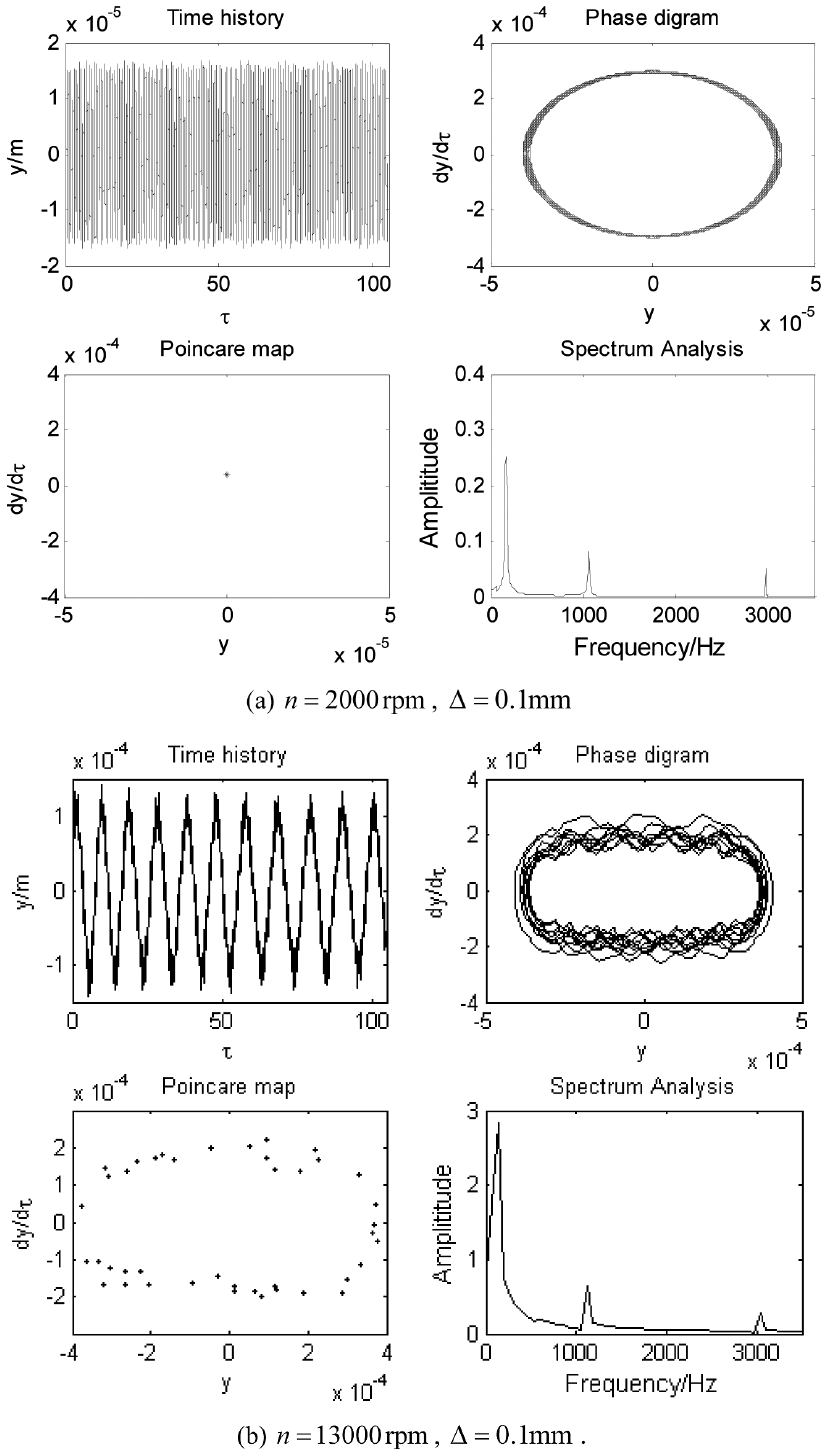
Fig. 4. Responses of the system at rotating speed 2000 rpm and 13000